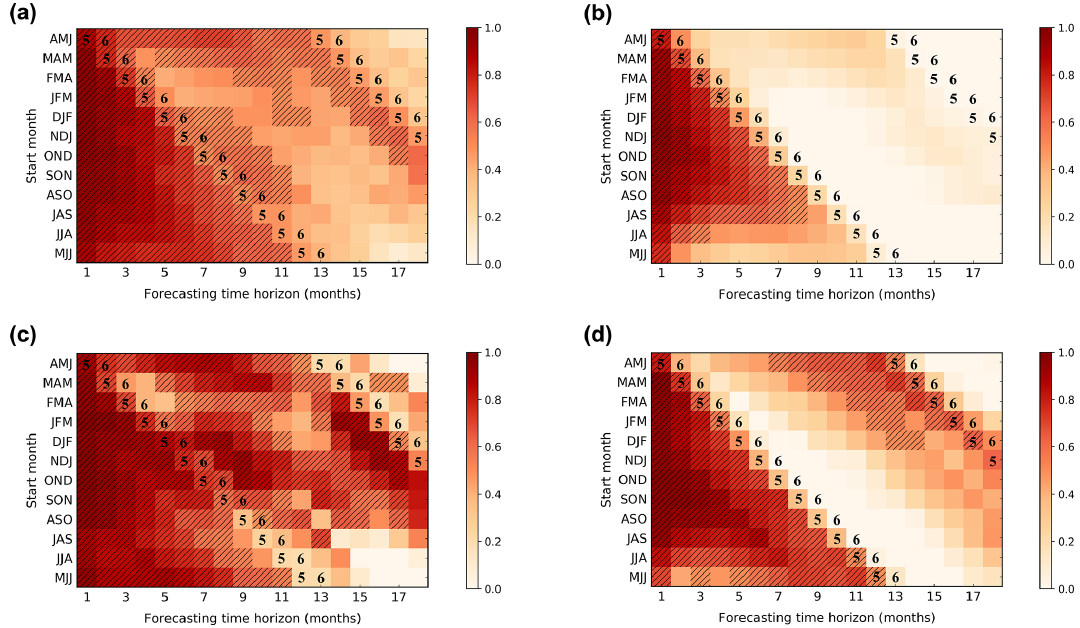
Figure 13. The correlation skills of the Niño 3.4 index forecasts started from each calendar month in ENSO-MC using the multistep forecast strategy (a) and the one-step-ahead forecast strategy (b) for the GODAS data from 1982 to 2019. Panel (c) is the same as (a) , except for the GODAS data from 2010 to 2019. Panel (b) is the same as (d) , except for the GODAS data from 2010 to 2019. Hatches represent the forecasts with correlation skill exceeding 0.5, and the black numbers mean the target forecast